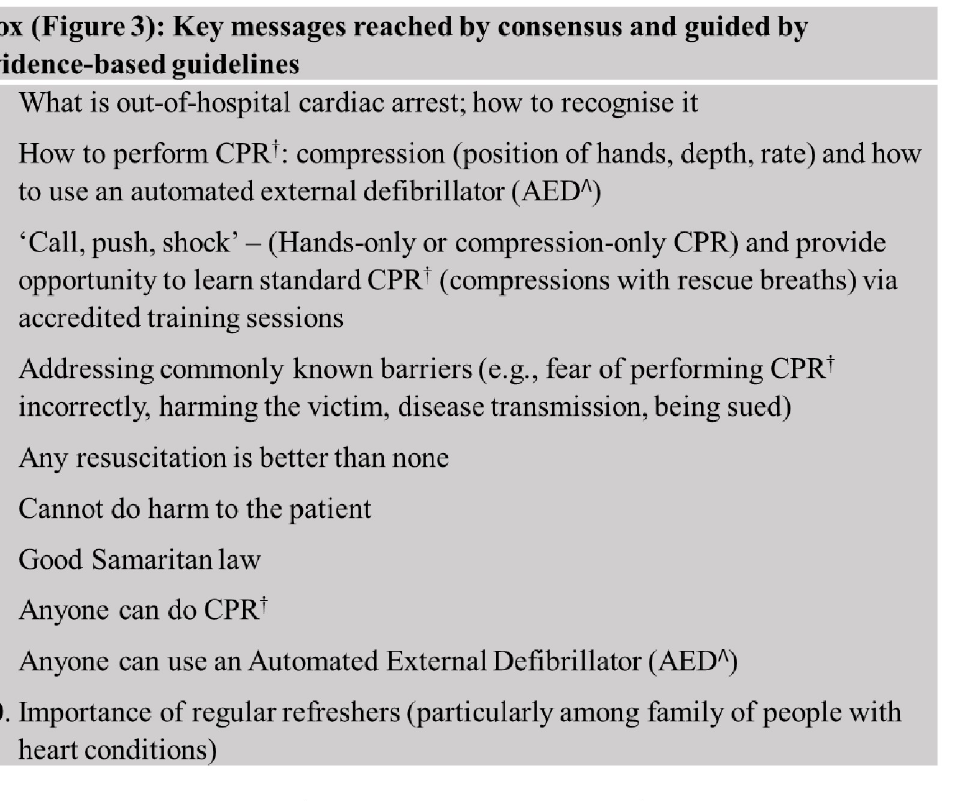
Fig 3. Box: Key messages reached by consensus and guided by evidence-based